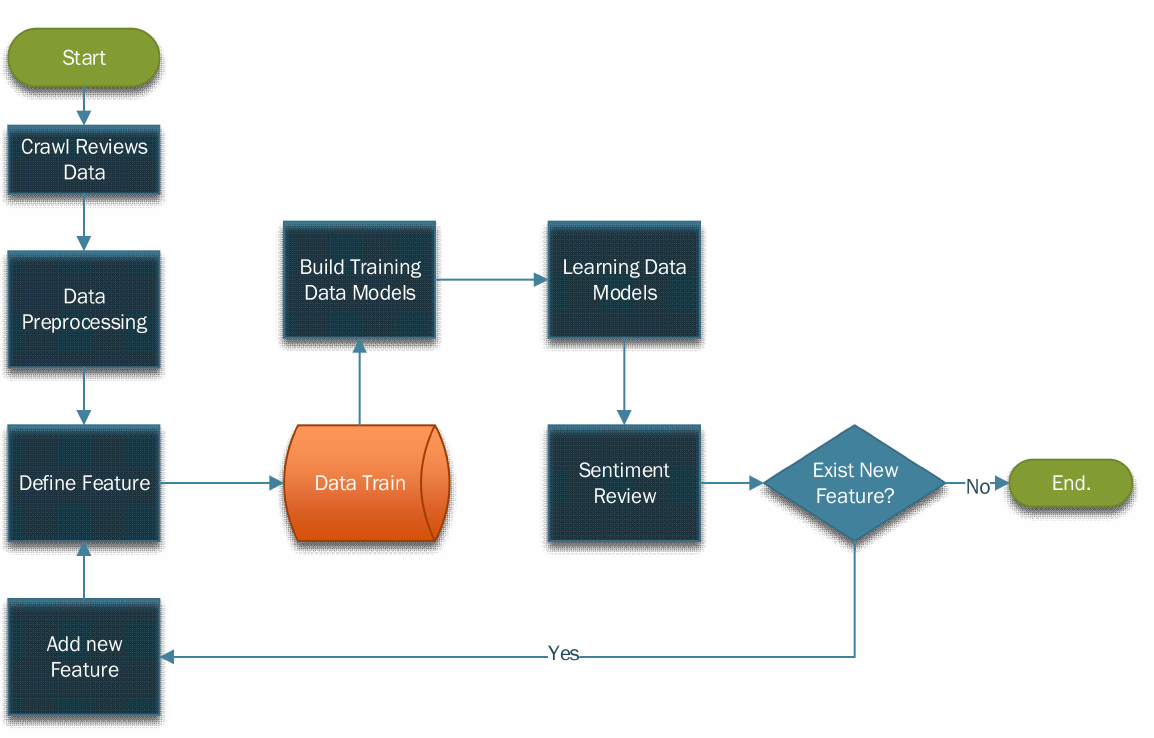
Figure 3. Research